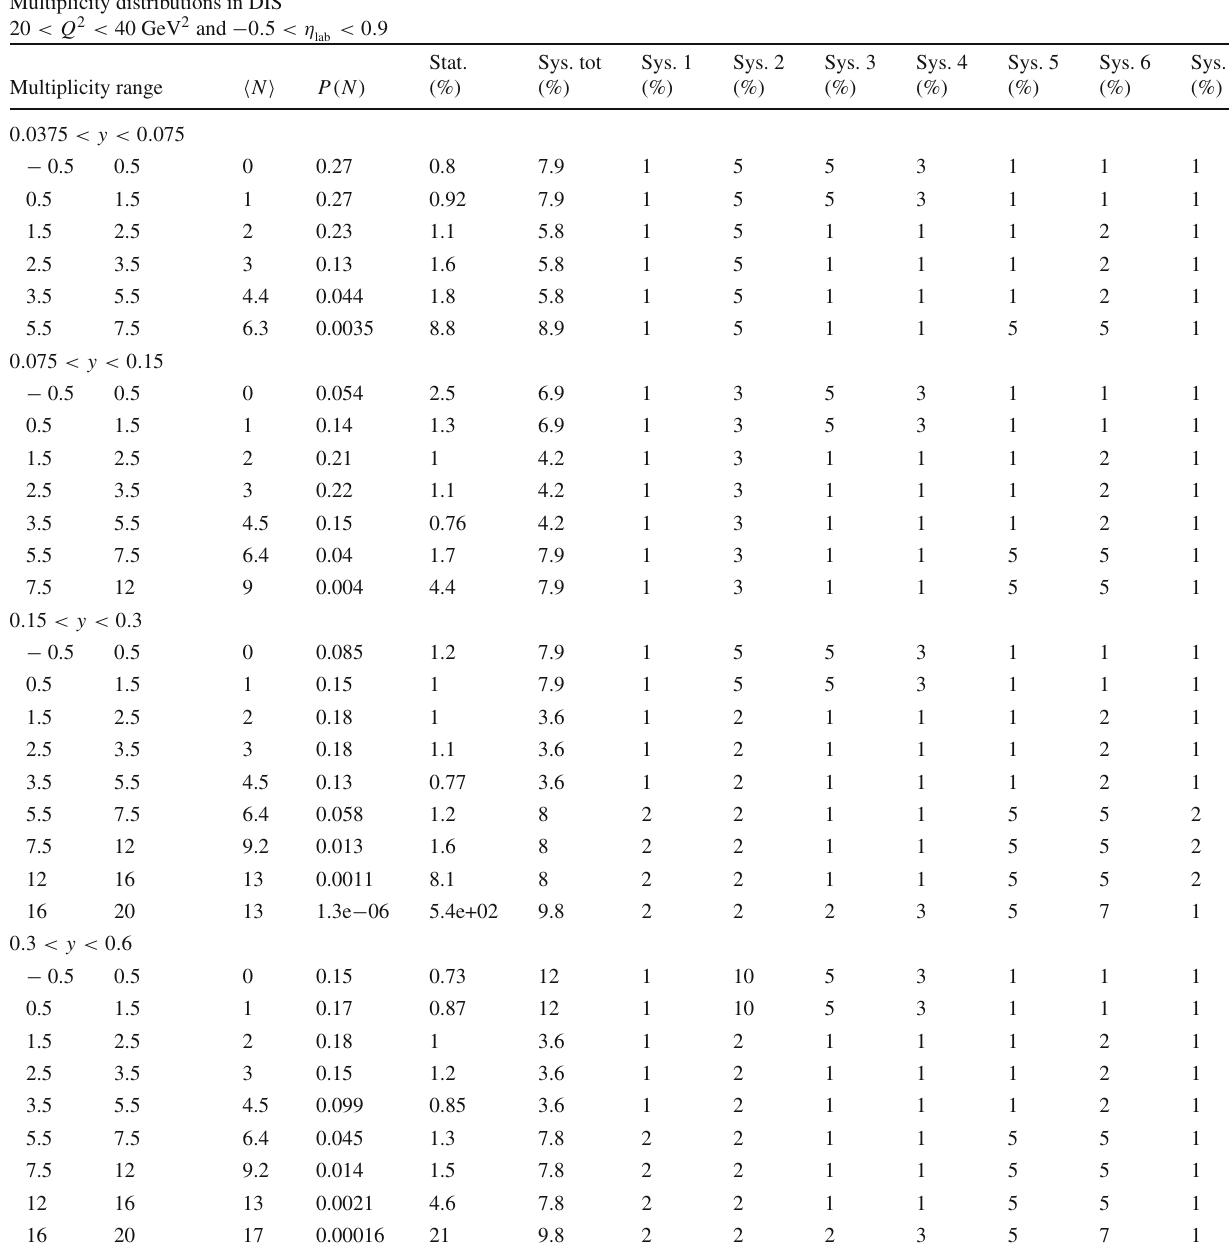
Table 20 Charged particle multiplicity distributions P ( N ) measured √ s = 319GeV with in the ranges of photon virtual- in ep DIS at ity 20 < Q 2 < 40 GeV 2 and charged particle pseudorapidity range Multiplicity distributions in DIS < 0 . 20 < Q 2 < 40 GeV 2 and − 0 . 5 < η lab